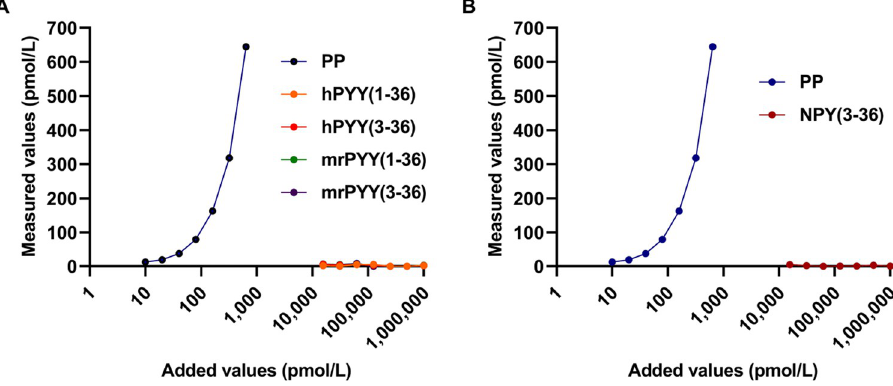
Fig 1. Cross-reactivities of the PP ELISA system with other NPY family peptides. PP concentrations measured by the PP ELISA system after the addition of synthetic peptides PP (A, B), PYY (A) or NPY (B) with adjusted concentrations. hPYY: Human PYY; mrPYY: Mouse and rat PYY, which have the same amino acid sequence.